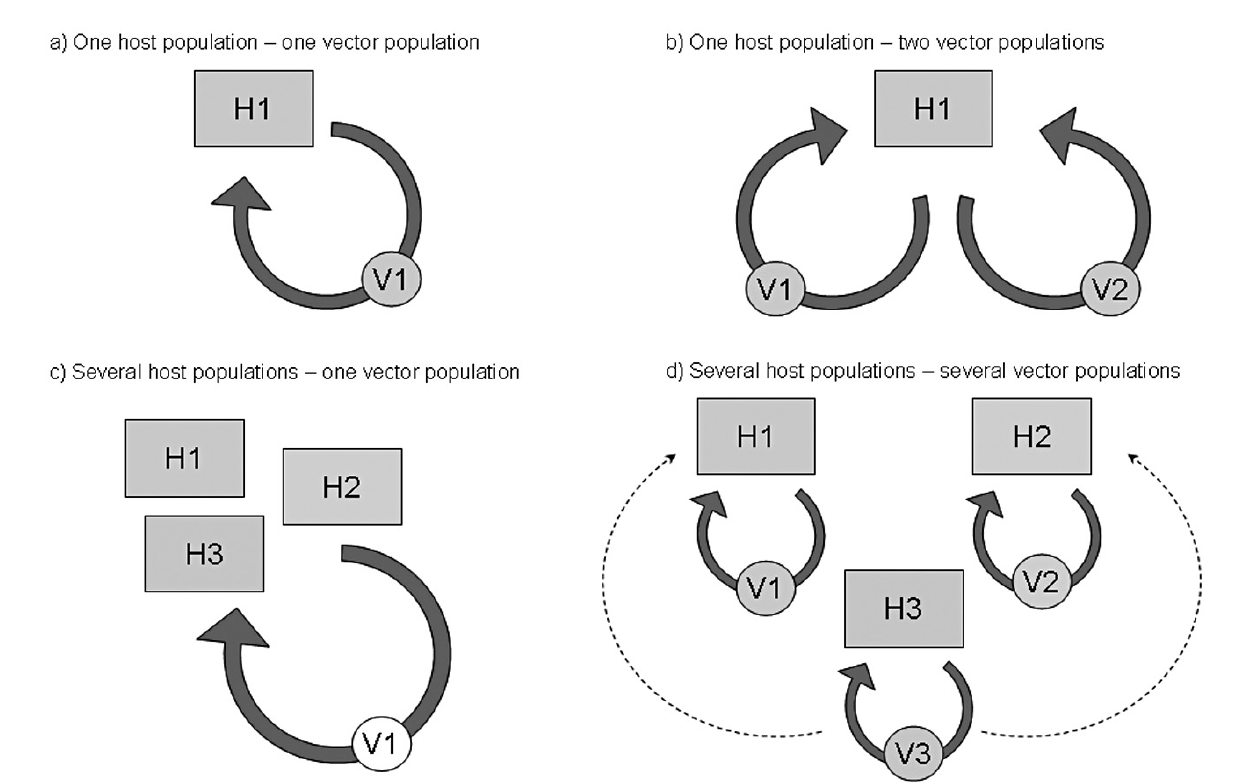
Fig. 1. – Different types of local interactions depending on the population structure of the vector. a) The simplest scenario where a micro- parasite circulates between one host population and a single vector population. In this case, the microparasite may adapt to efficiently exploit the vector and vertebrate host. b) The vector shows population structure, but both populations exploit the same host population. Here, the microparasite can circulate in both vector populations, but selection in the vector will occur independently (could result in one vector becoming more competent than the other or in the evolution of two microparasite populations via divergent selection). c) Several host species are available locally, but all are equally used by the vector (the vector is a generalist). In this case, the evolution of the micro- parasite will depend on relative selection pressures imposed by the different hosts. d) Each vertebrate host species is exploited by one vector population resulting in locally independent or semi-independent disease cycles. The outcome of these interactions will depend on the specificity of the different vector populations (dotted line) and the ability of the microparasite to exploit different hosts after trans-